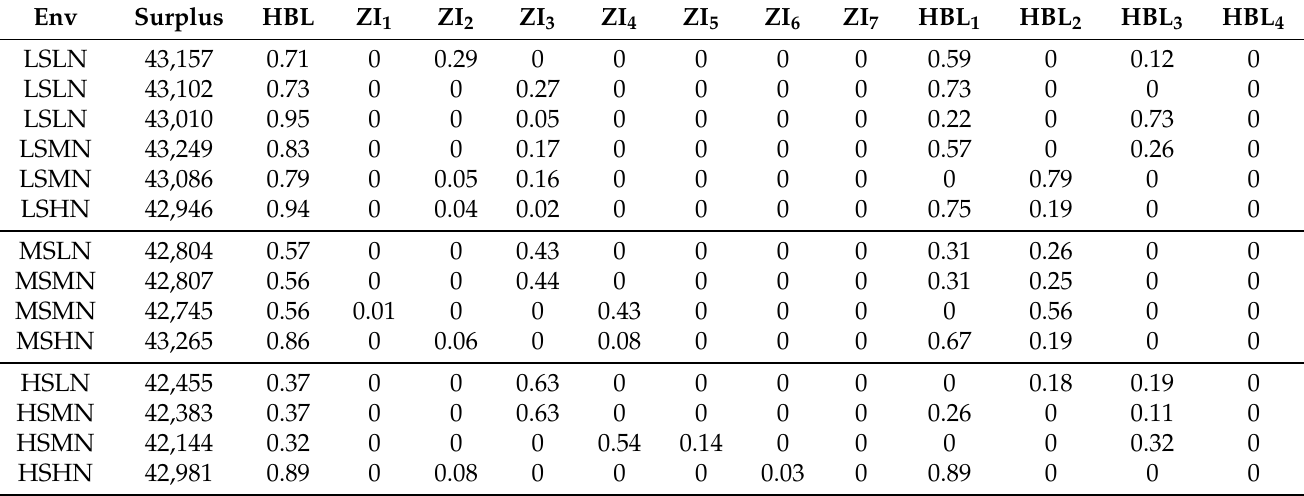
Table A6. Equilibria for games without spoofing, N = 65, calculated from the five-player DPR approximation. Each row of the table describes one equilibrium found with its corresponding surplus, HBL adoption rate and the equilibrium mixture probabilities of strategies included.